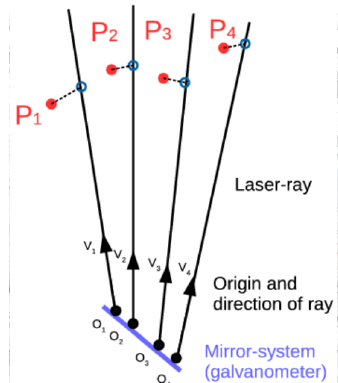
Figure 3. Representation of the non-Perspective-n-Point problem with a laser galvanometer. The laser rays ( O i , V i ) are described in the laser galvanometer coordinate system while laser dots ( P i ) are described in the range sensor coordinate